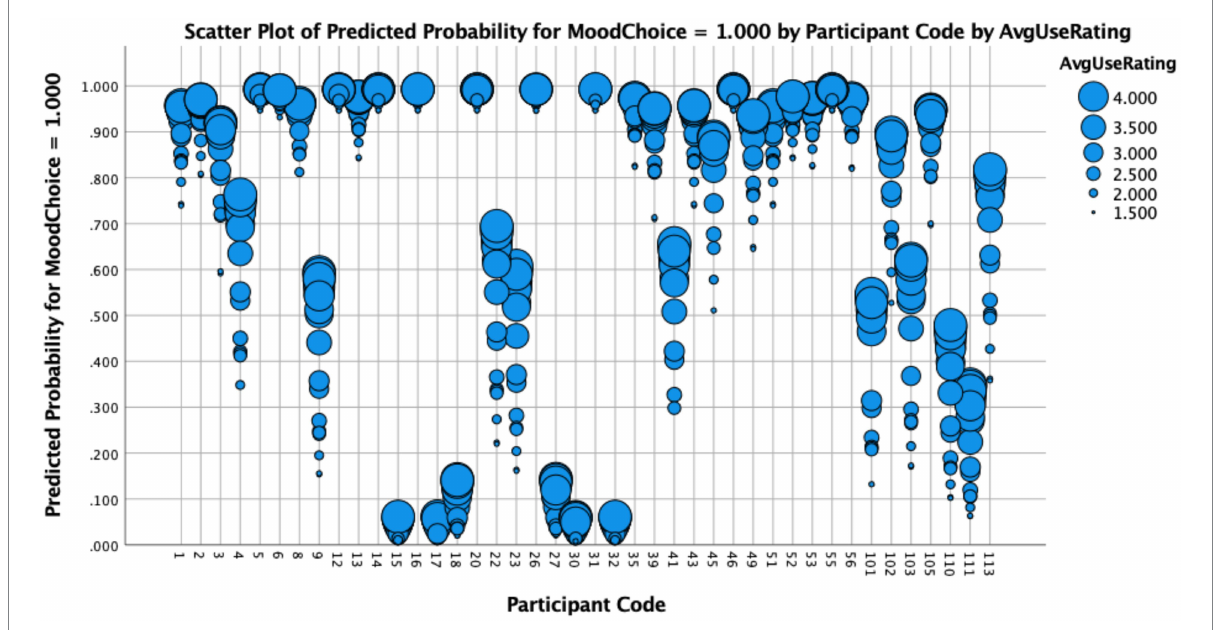
FIGURE 1 Individual participants’ predicted probability of subjunctive use as a function of self-reported average